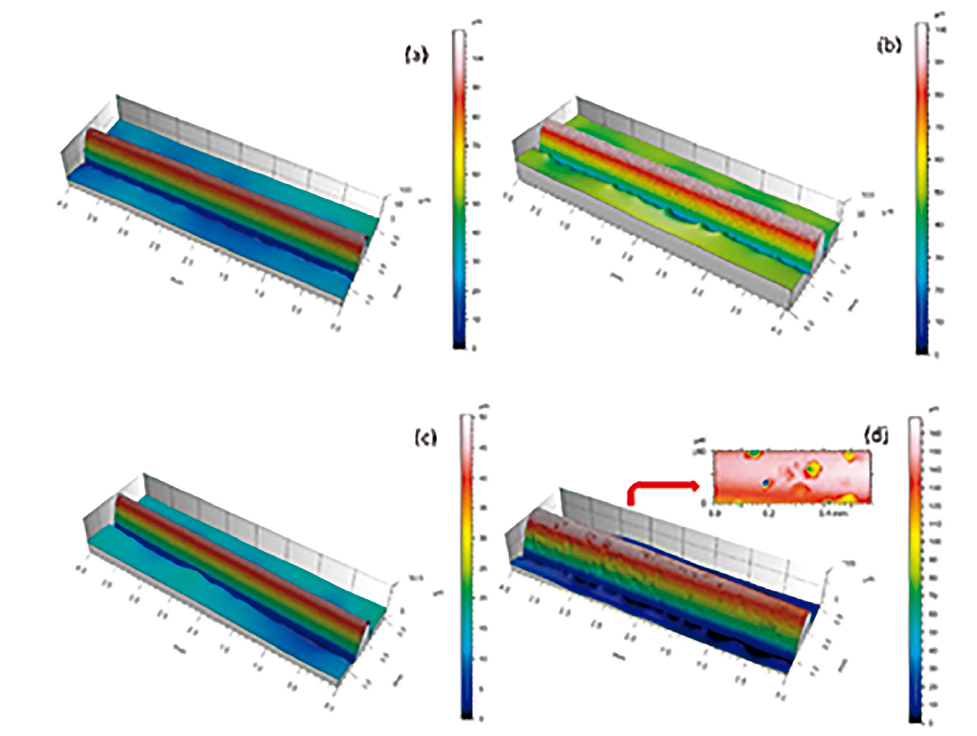
Figure 6. 3D reconstruction obtained from confocal analysis of NiTi (a,b) and NiTiCu (c,d) raw material before (a,c) and after (b,d) polarization. An approximate view is pointed by the arrow for the NiTiCu surface after (d)